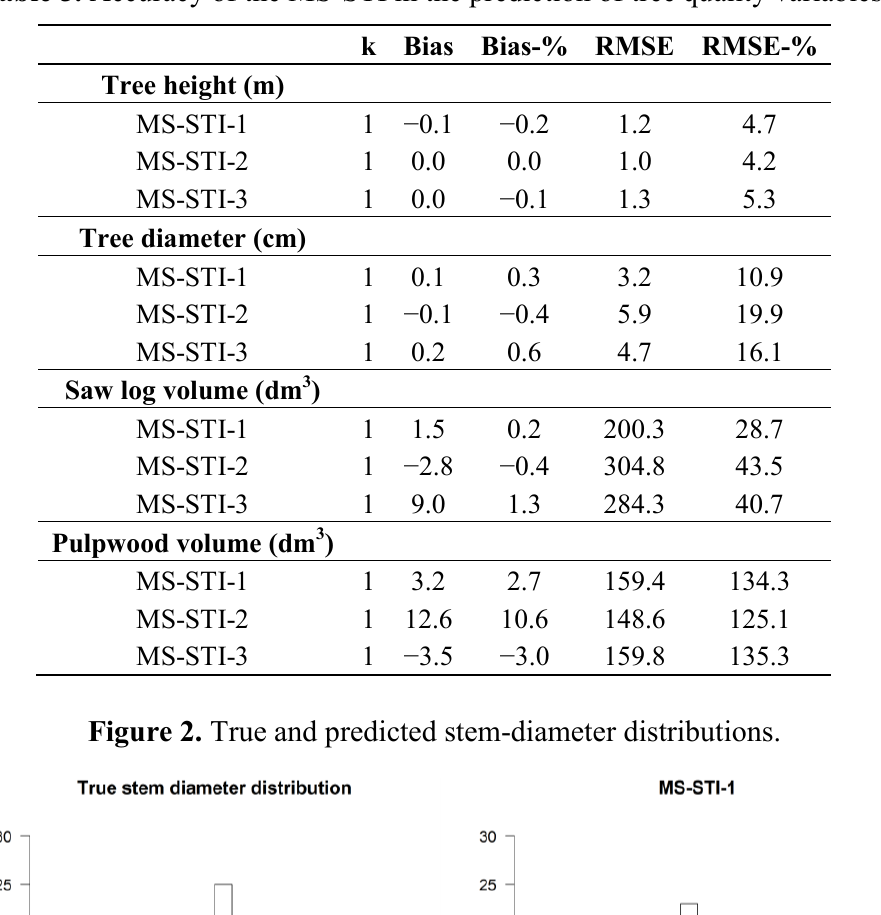
Table 5. Accuracy of the MS-STI in the prediction of tree quality variables.